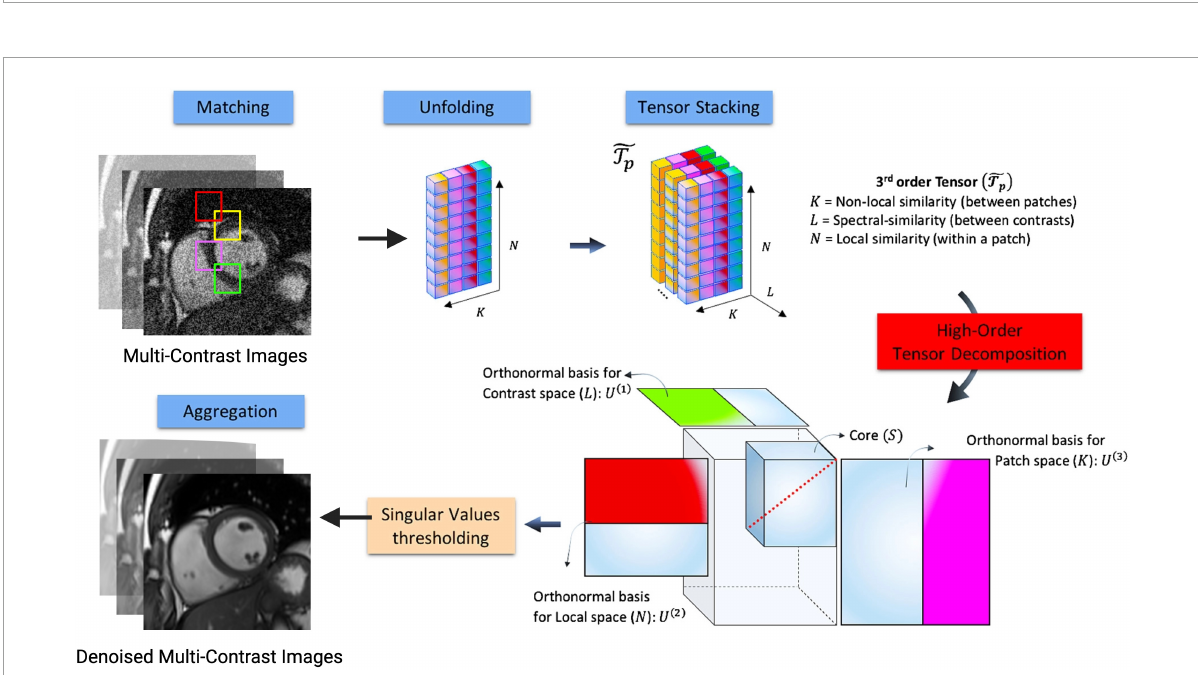
FIGURE7 Flowchart describing the denoising HD-PROST optimization proposed by Bustin et al. (36). Multi-contrast images are denoised using 2D and 3D block matching, respectively, grouping similar 2D and 3D patches in the multi-contrast images. In a simple 2D matrix, these patches are then unfolded, and a third-order tensor is formed by stacking them in the contrast dimension. Through tensor decomposition, the high-order tensor can then be compressed. This is done by truncating multilinear singular vectors corresponding to small multilinear singular values. This process outputs denoised, multi-contrast images which are then used as prior knowledge in the joint MR reconstruction. Figure adapted from Bustin et al.